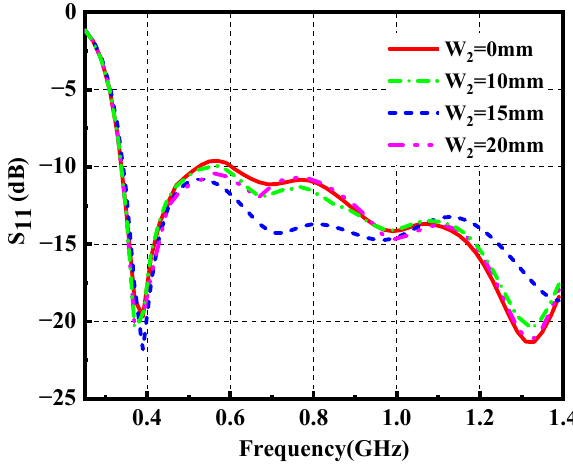
Figure 6. Simulated S 11 of the Ant-3 with the variation of the W 2 . Table 1. Geometrical parameters of the proposed antenna.